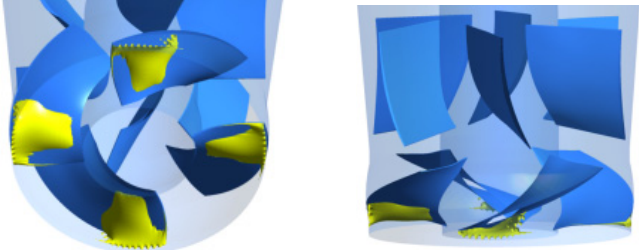
Figure 5. The area below the pressure threshold in the impeller.